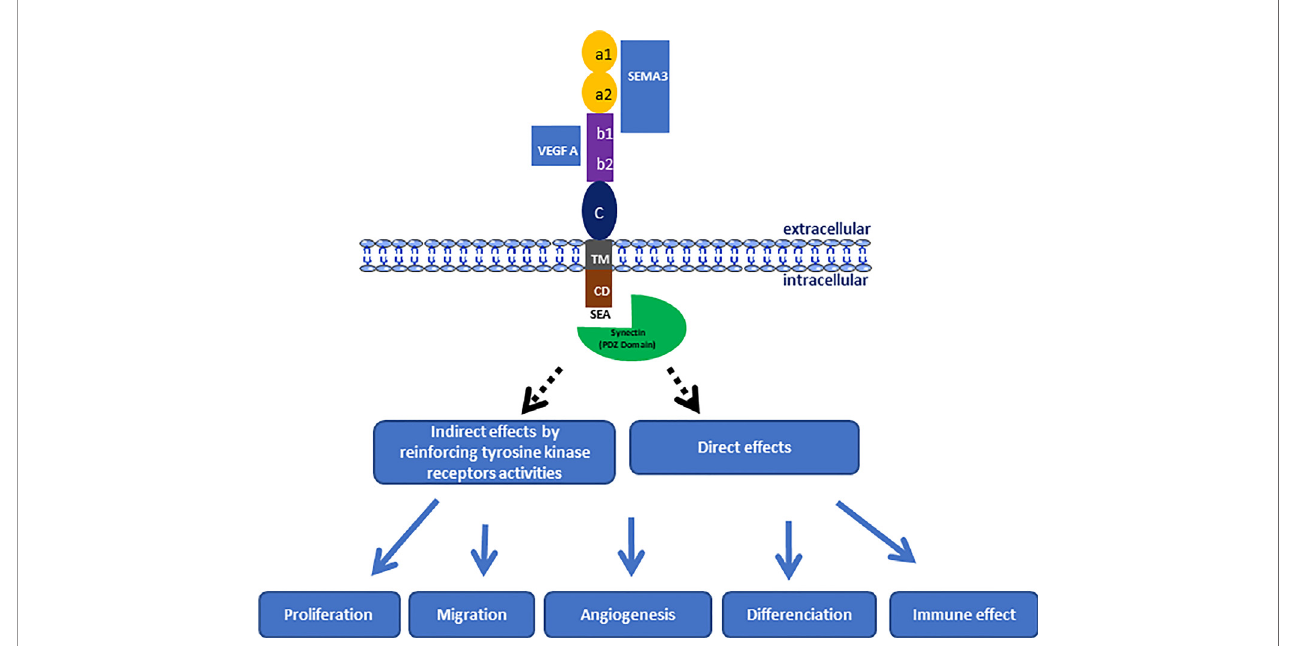
FIGURE 1 | Schematic representation of NRP-1 structure indicating the link regions of natural ligands and its involving in the progression of pediatric brain tumors through the control of different biological